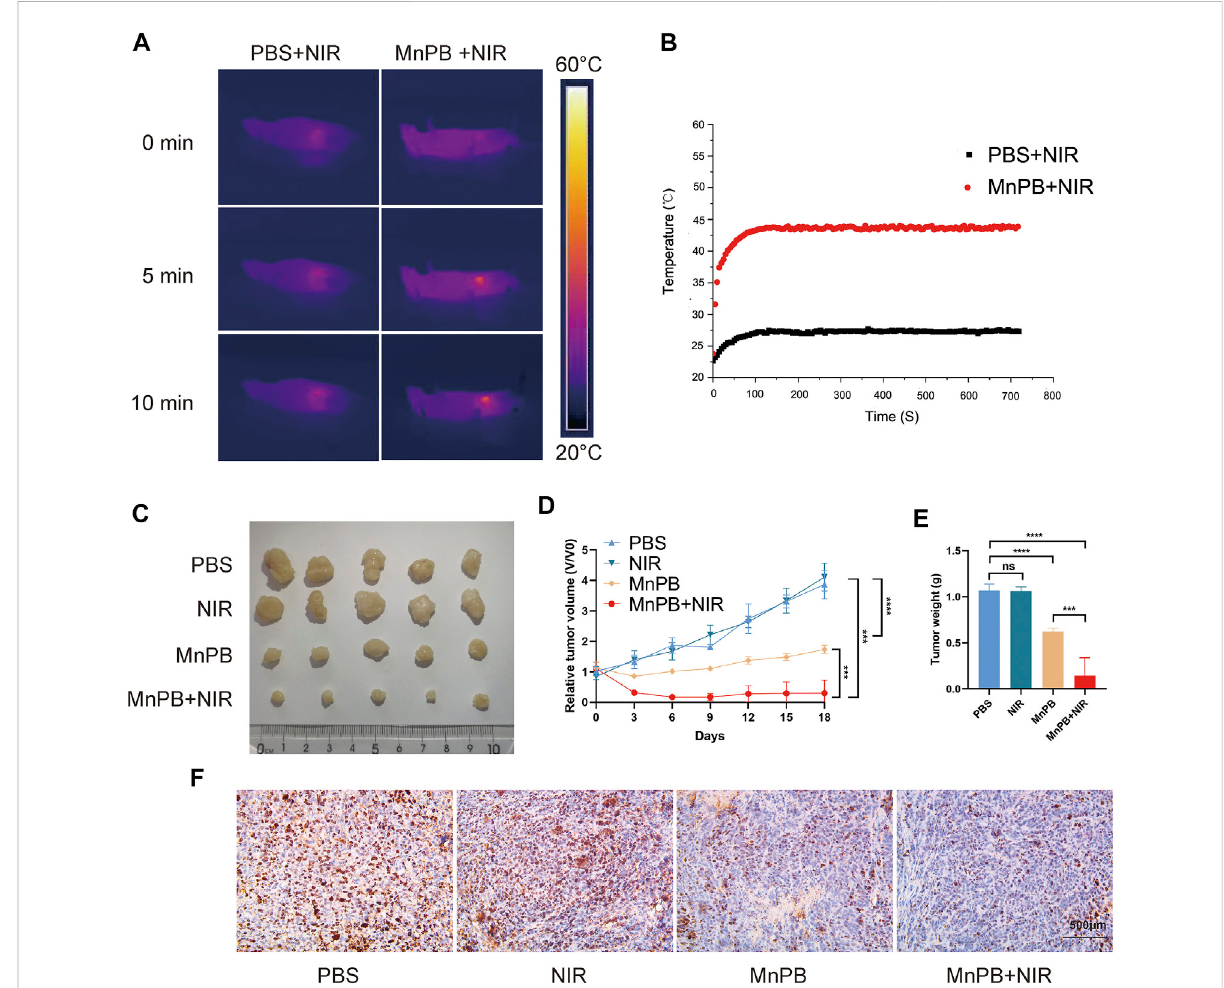
The MnPB NPs inhibit the proliferation of PANC-1 cells in vivo (A) The infrared thermography pictures of mice under laser irradiation. (B) Pro fi le of temperature in the tumor site. (C) Digital pictures of each group after varied treatments. (D) The tumor volume changes over 18 days. (E) Differencesbetween theweightof thesubcutaneous tumors with different treatments. (F) The immunohistochemical stain imagesof ki67 in groups with different treatments. * p < 0.05; ** p < 0.01; *** p < 0.001; **** p < 0.0001; ns: no signi fi